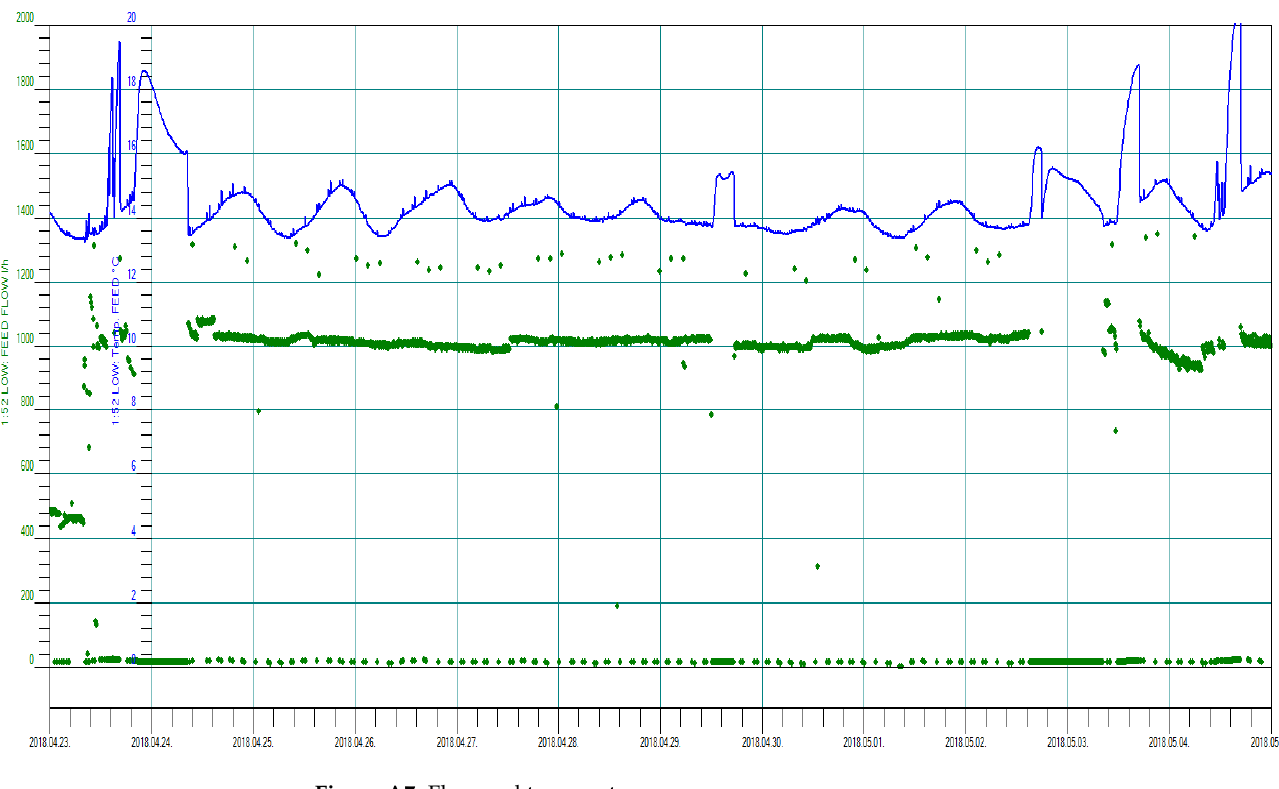
Figure A6. Flow and TMP.